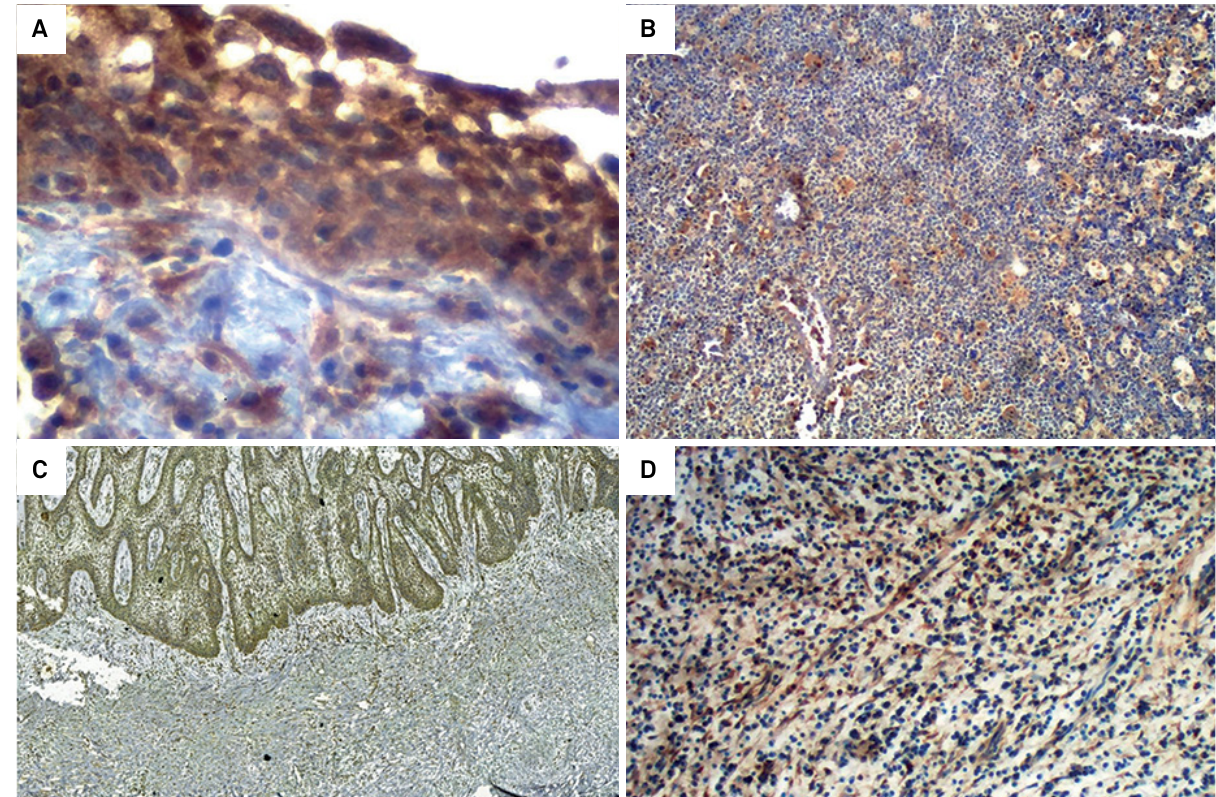
Figure 1. Representative photomicrographs of immunohistochemical staining of the studied markers in periapical lesions. (a) MMP-9 expression in radicular cysts (IHC, 200X), (b) MMP-9 expression in periapical granuloma (IHC, 100X), (c) TGF- β 1 expression in radicular cysts (IHC, 100X), (d) TGF- β 1 expression in periapical granuloma (IHC,